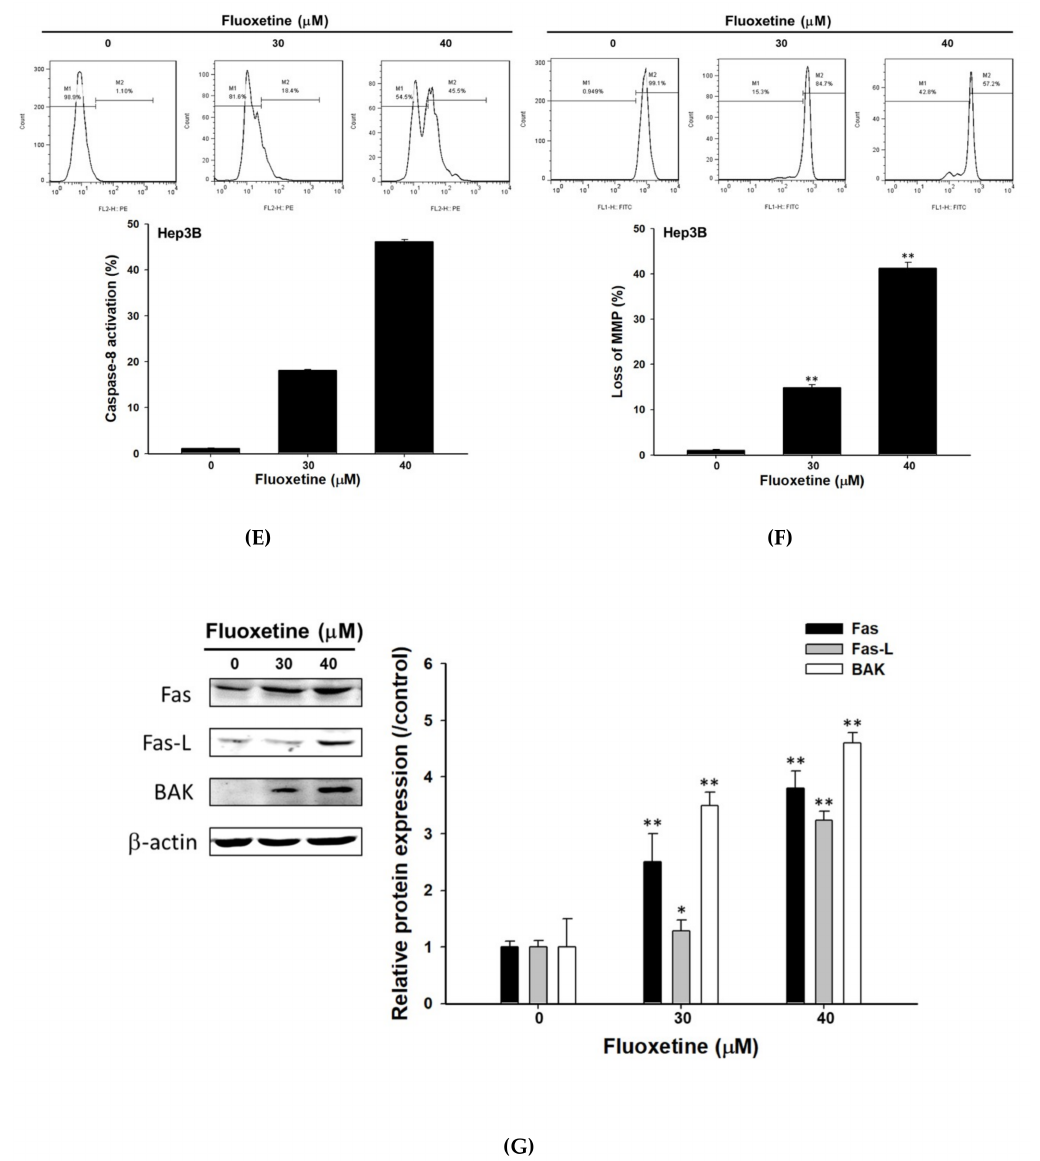
Figure 3. Fluoxetine modulated extrinsic and intrinsic apoptosis pathways in SK-Hep1 and Hep3B cells. Cells were treated with different concentrations (0, 30, and 40 µ M) of fluoxetine for 48 h, respectively. Extrinsic and intrinsic apoptotic signaling was determined by flow cytometry and western blotting assay. Activation of ( A ) Fas, ( B ) FasL, and ( C ) caspase-8 was determined on SK-Hep1 cells with flow cytometry. ( D ) Detection of ∆Ψ m on SK-Hep1 cells by flow cytometry. ( E ) Detection of caspase-8 activation on Hep3B cells. ( F ) Detection of ∆Ψ m on Hep3B cells. ( G ) Protein levels of Fas, FasL, and BAK on SK-Hep1 cells were investigated with Western blotting assay. Quantification data were normalized by β -actin expression and averaged over three repeated experiments. * p < 0.05, ** p < 0.01, significant difference between control and fluoxetine-treated